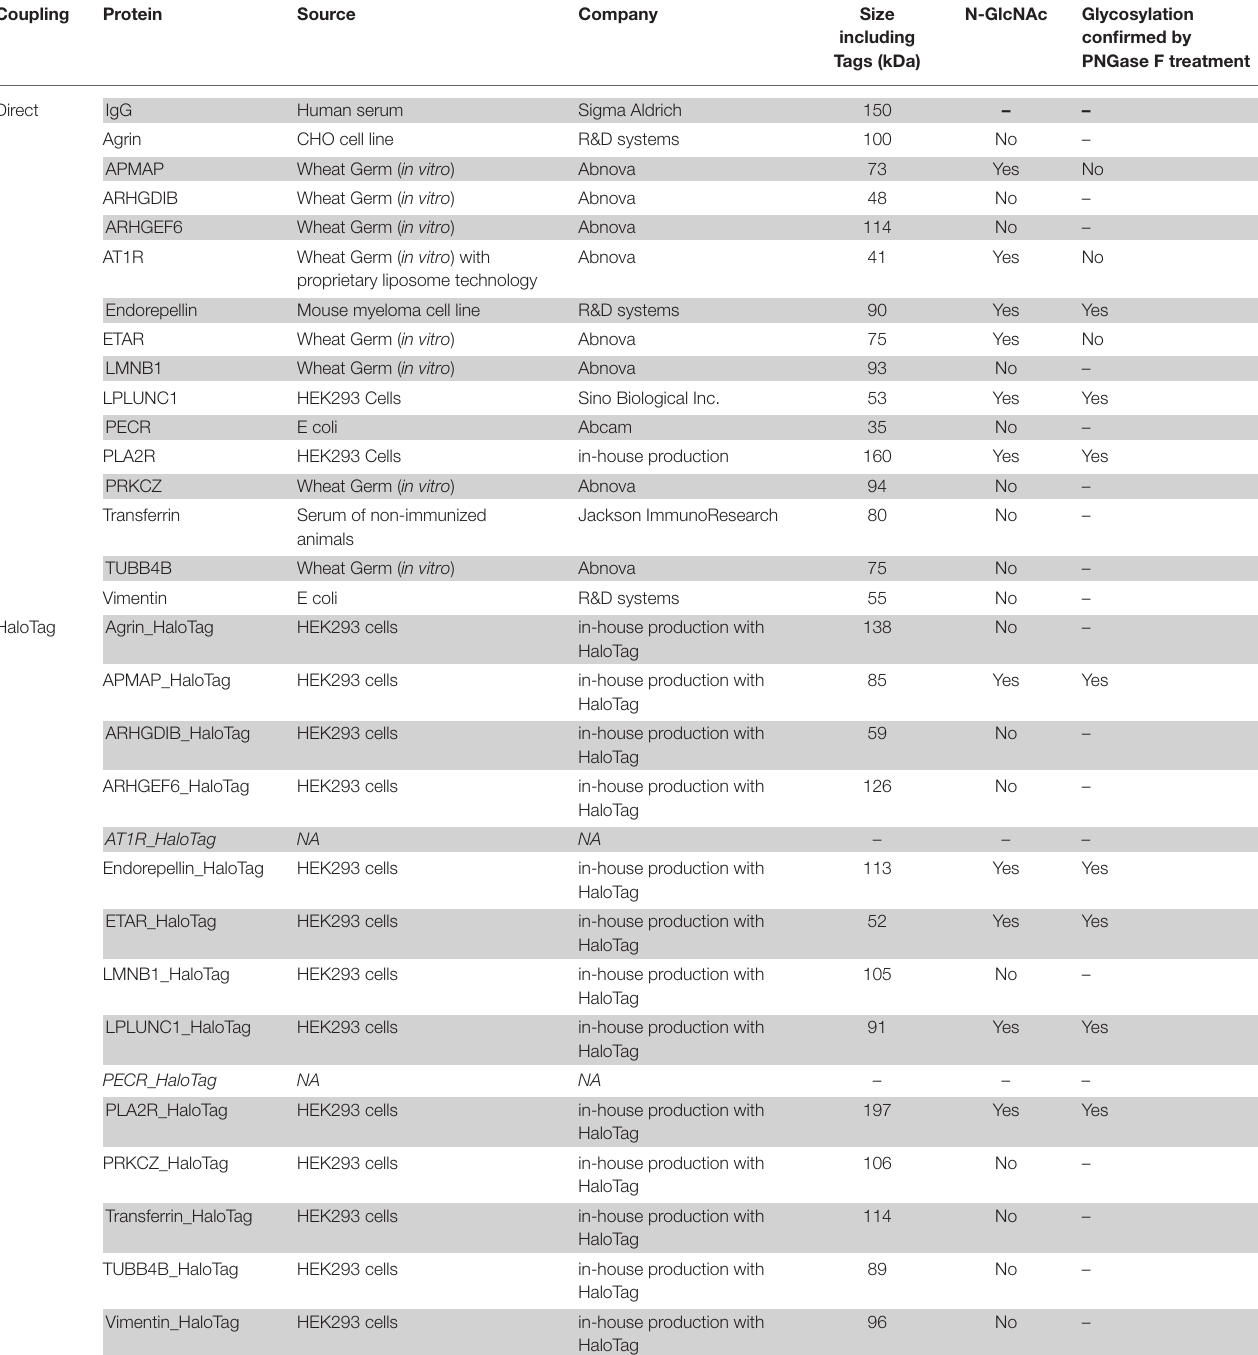
TABLE 2 | Overview of all purchased and in-house produced proteins.